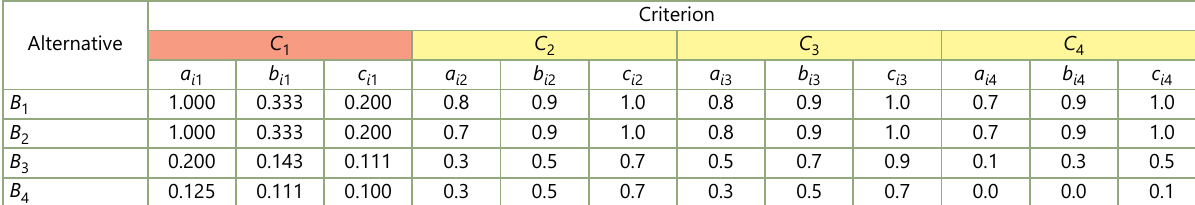
Table 14. The normalized fuzzy decision matrix R G ( l ) (source: own contribution)